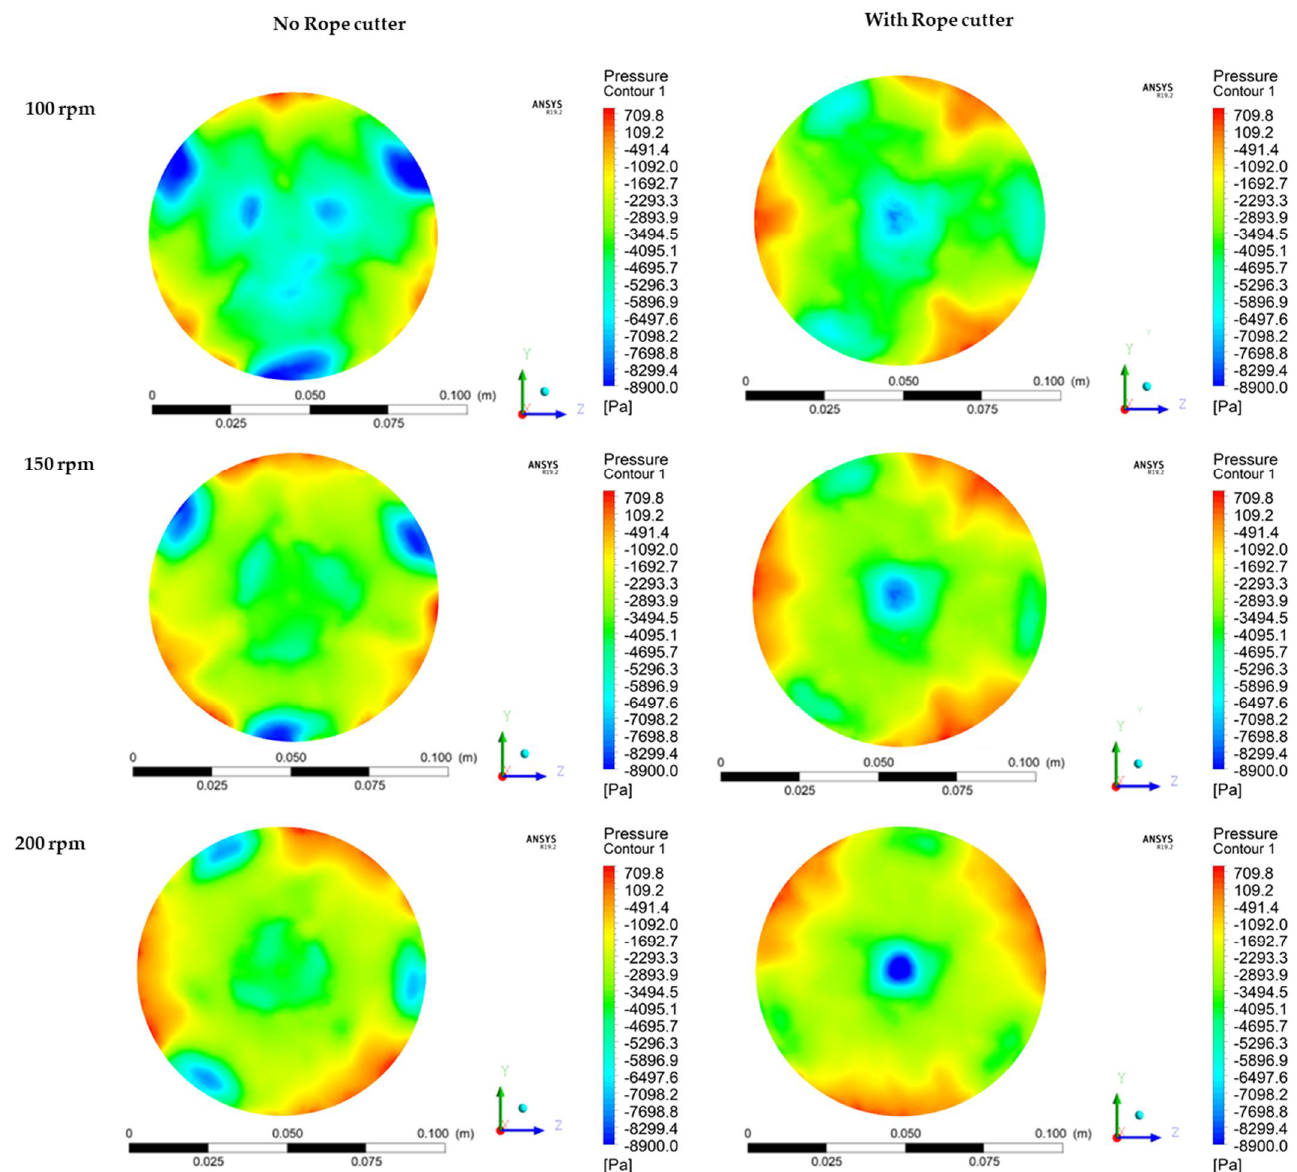
Figure 19. Pressure distribution on the transverse plane behind the propeller